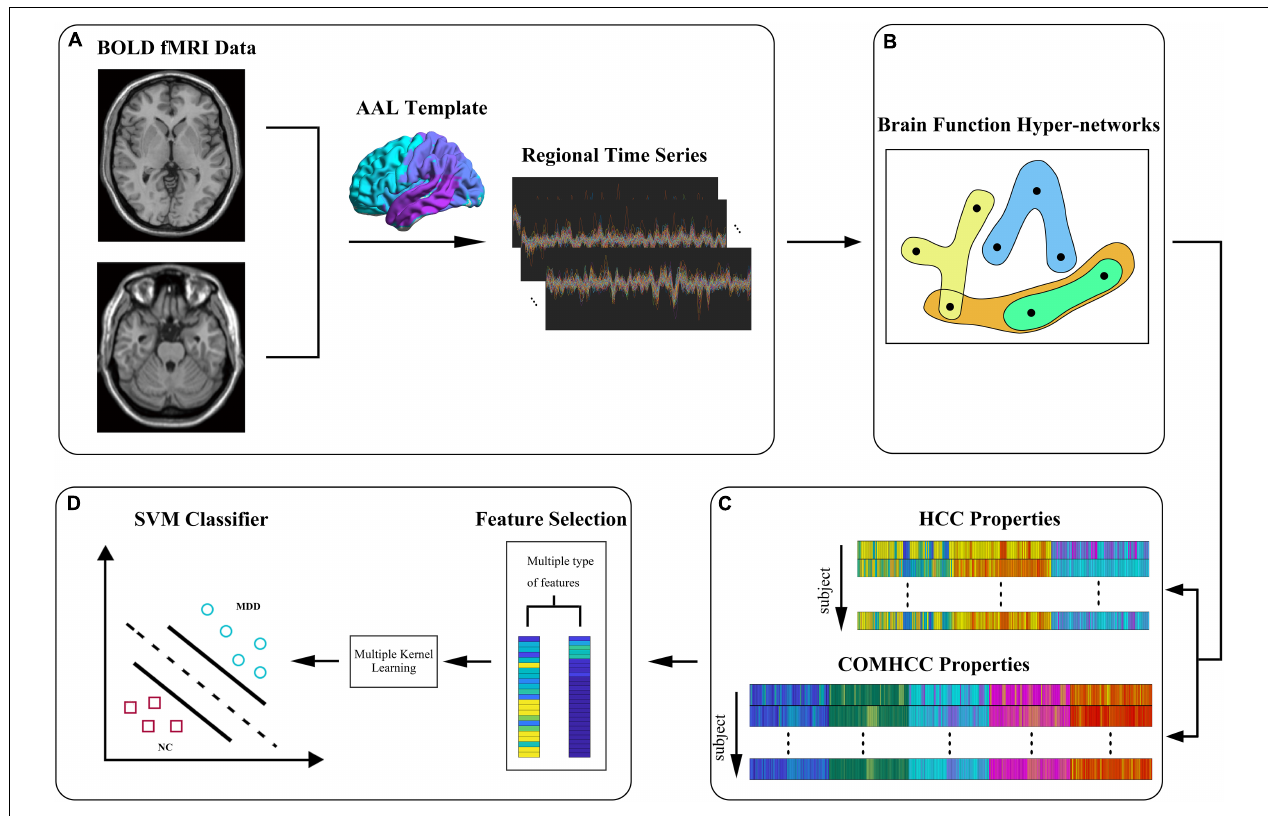
FIGURE 1 | The flowchart of experimental process, including (A) data acquisition and preprocessing, (B) brain functional hypernetwork construction, (C) feature extraction based on two types of features, and (D) feature selection and